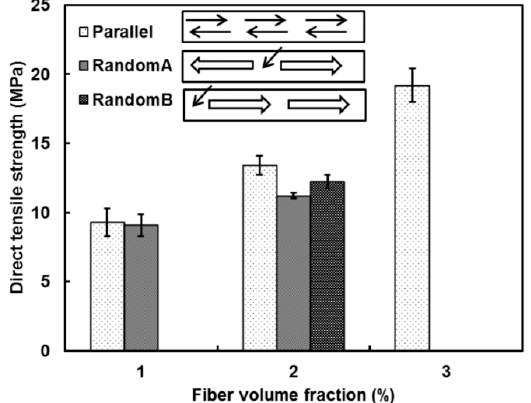
Figure 7. Average maximum stress of UHPC under uniaxial tension [7].